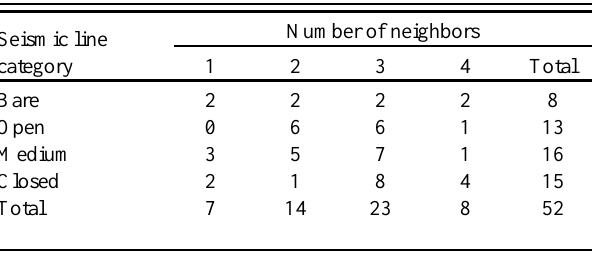
Table 1 . Conspecific density and line category combinations: